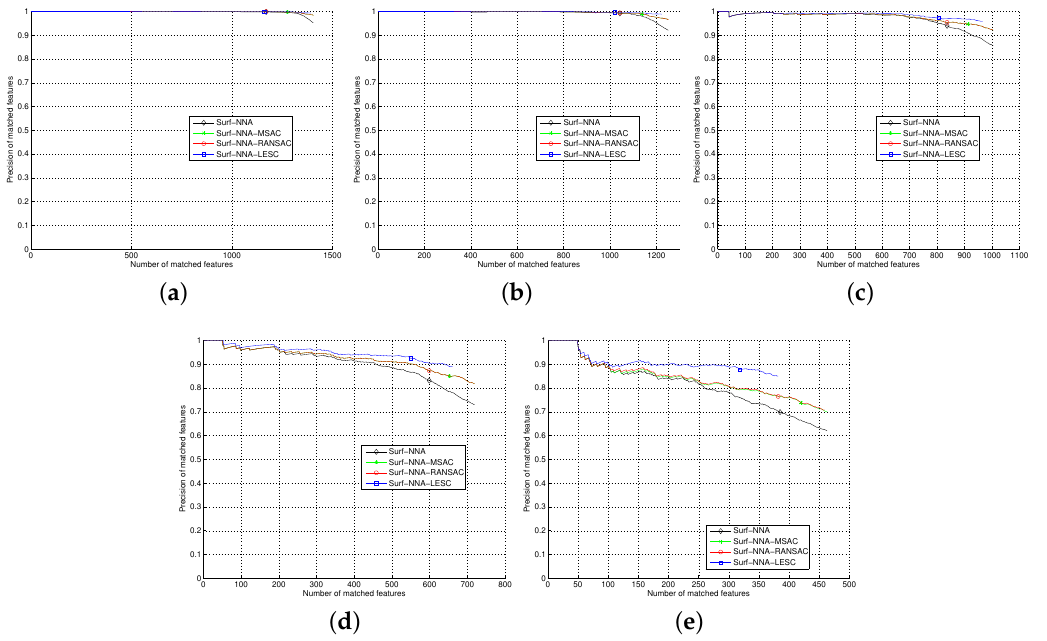
Figure 5. JPEG compression by the UBC sequence. From ( a ) to ( e ) the degree of change